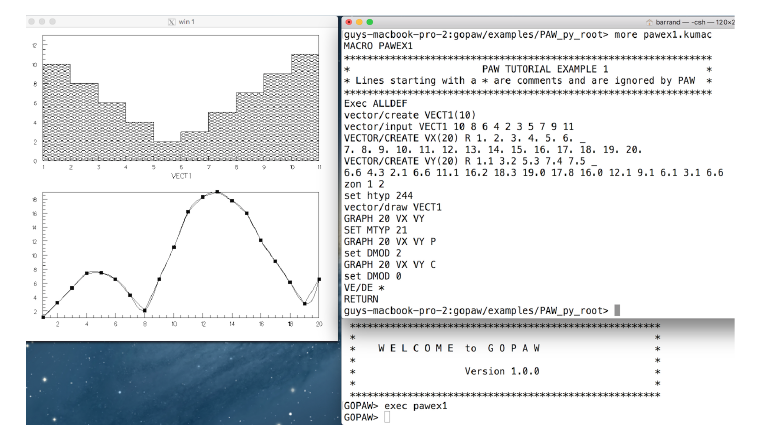
Figure 2. pawex1.kumac with gopaw